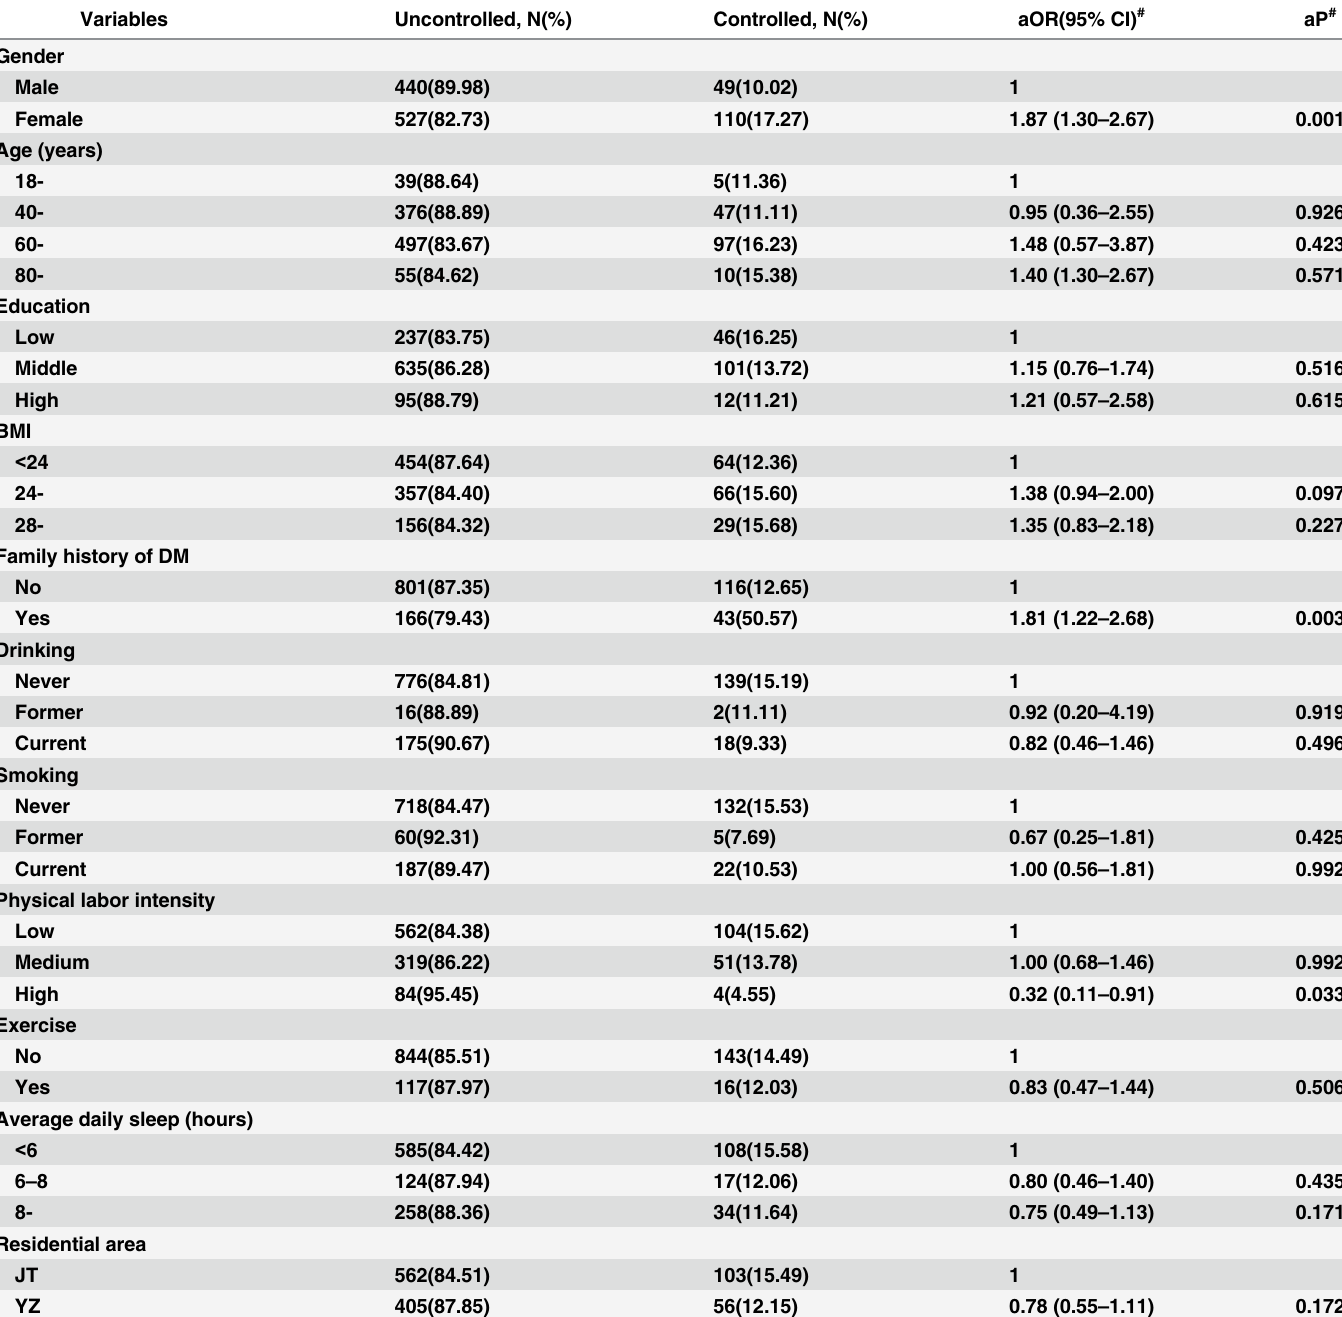
Table 6. Factors associated with diabetes mellitus